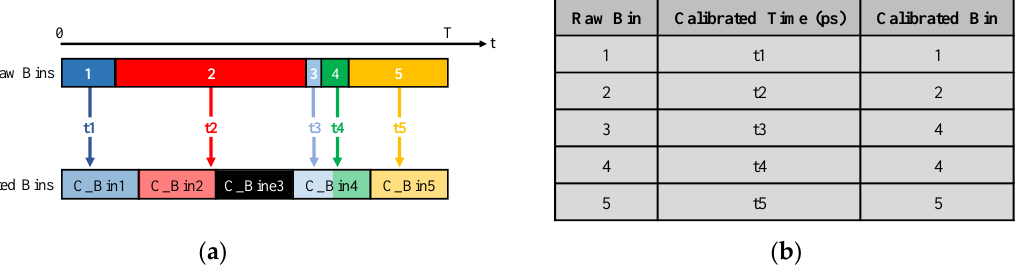
Figure 3. Bin-by-bin calibration: ( a ) Calculating the calibrated times and calibrated bins of the raw bins; ( b ) Bin-by-bin calibration lookup table.